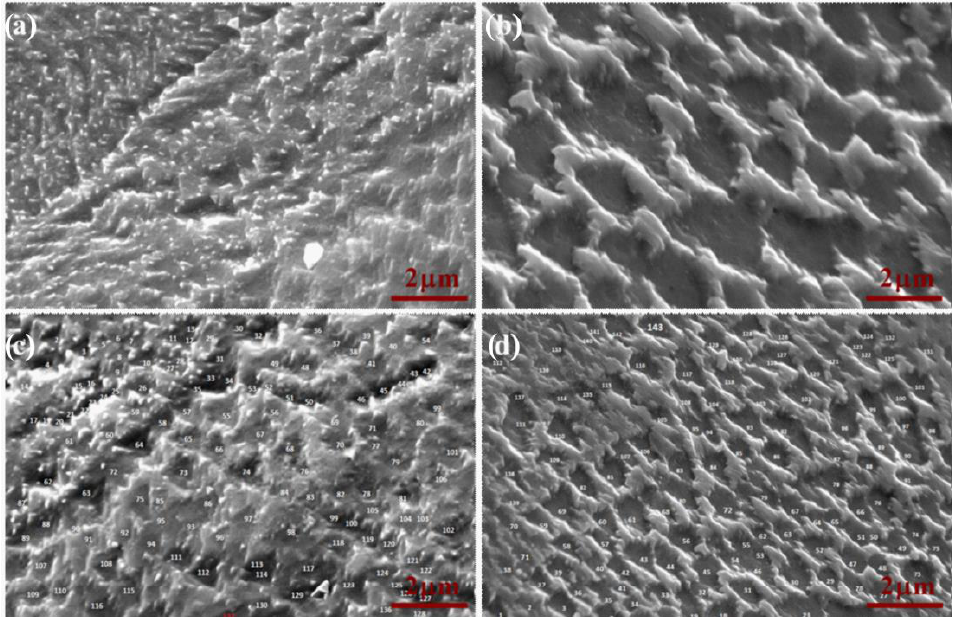
Figure 4. SEM images of the sphere compacted at 196.5 MPa: ( a ) etching pits in contact zone along the direction of compaction and ( b ) in the transversal plane at 10,000 × ; ( c ) Count of pits for the direction parallel to the pressure at 10,000 × and ( d ) transversal at 5000 ×